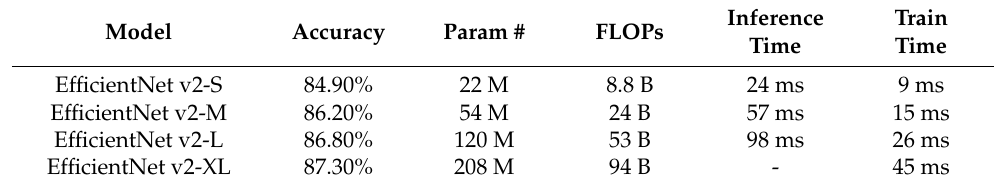
Table 4. Family models of EfficientNet v2 training on ImageNet.